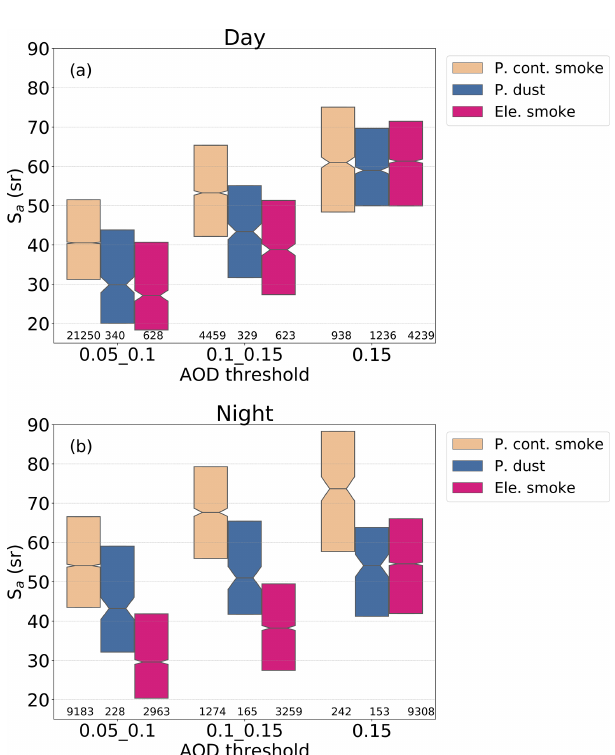
Figure 10. Median lidar ratios for AOD thresholds of 0.05,0.1, and 0.15 for daytime (a) and nighttime (b) retrievals. Median lidar ratio changes with AOD for dust and marine types remain within 6sr (not